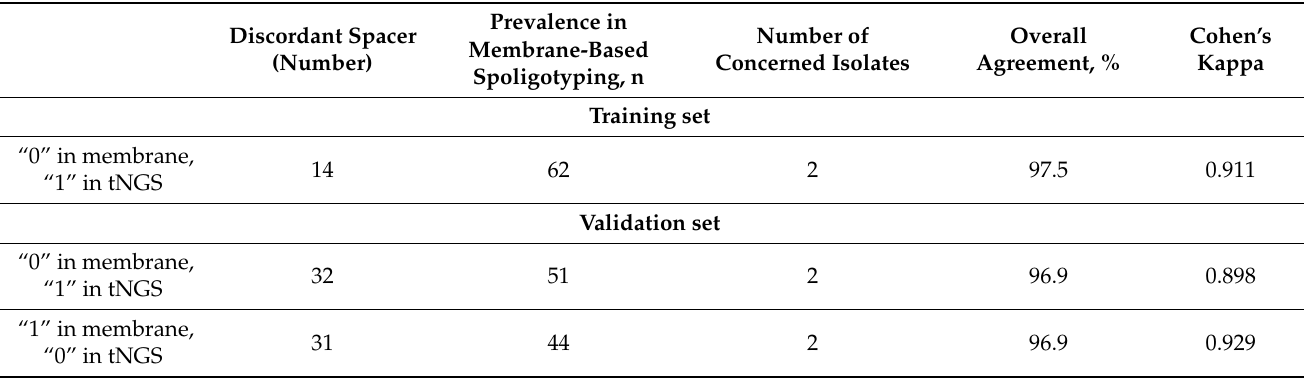
Table 1. Discordant spacers between membrane-based spoligotyping and tNGS spoligotyping for the training set and the validation